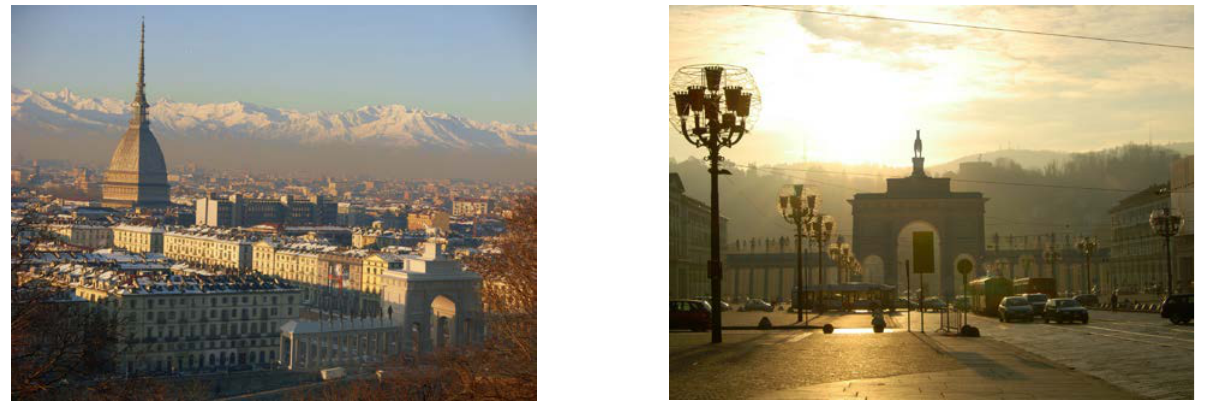
Figure 7. Photorealistic 3D models of the triumphal arch in Vittorio Emanuele square